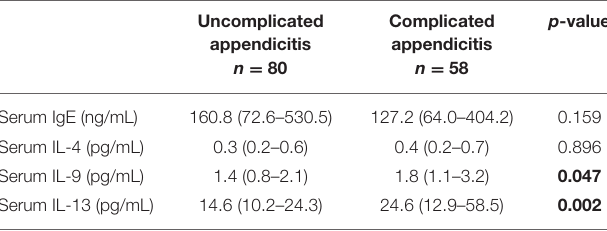
TABLE 1 | Demographics of 138 children with uncomplicated and complicated appendicitis. Uncomplicated appendicitis